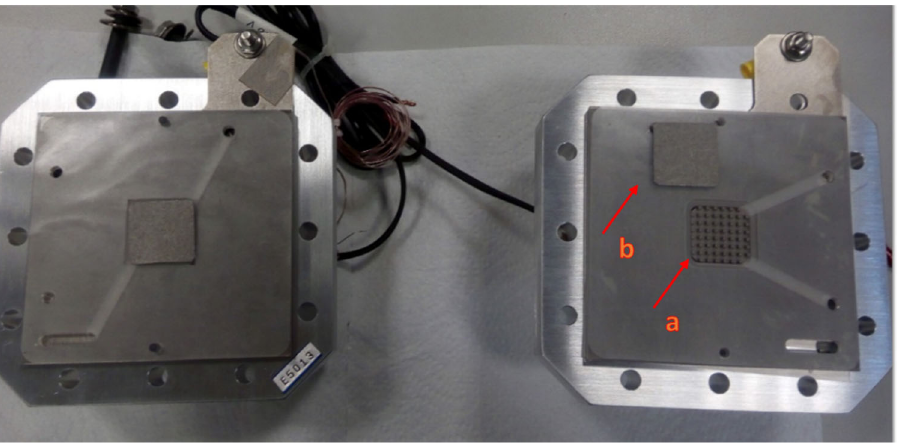
Figure 1. Open view of the commercial electrolyzer EC ‐ EL ‐ 05 from Electrochem. ( a ) Bipolar plates flow field, ( b ) PTL.